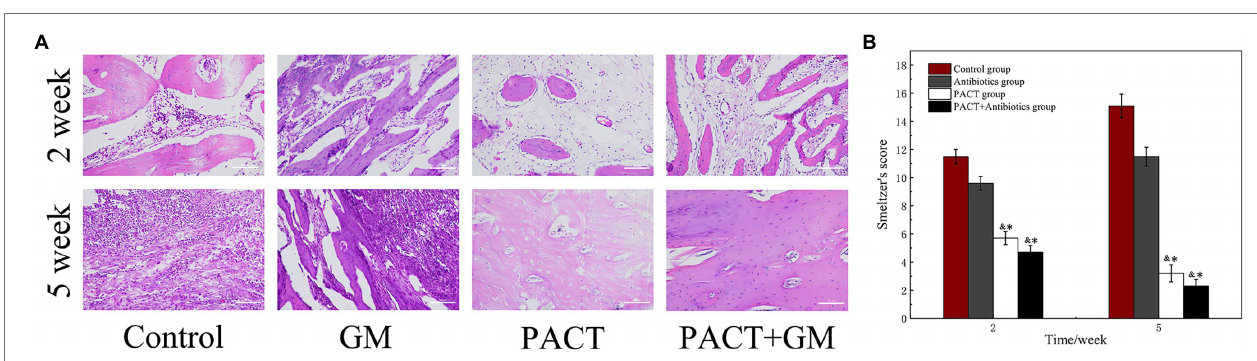
FIGURE 5 | Results of histological evaluation. (A) HE staining of the bone tissues in different groups at different times and (B) Smeltzer scoring of the bone tissues in the different groups. * p < 0.05 indicates a statistically significant difference compared with the control group, and & p < 0.05 indicates a statistically significant difference compared with the antibiotic group.